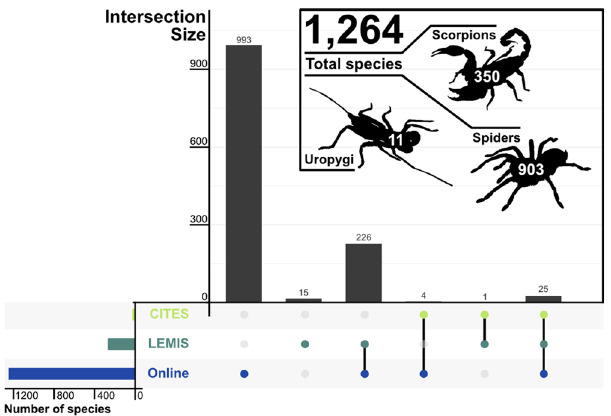
Fig. 1 UpSet plot showing how the three different sources overlapped. UpSet plot of how the three different sources overlapped in terms of species, with an insert showing how the total number of species was split between three major clades. Lower left hand bar chart shows the number of species detected via